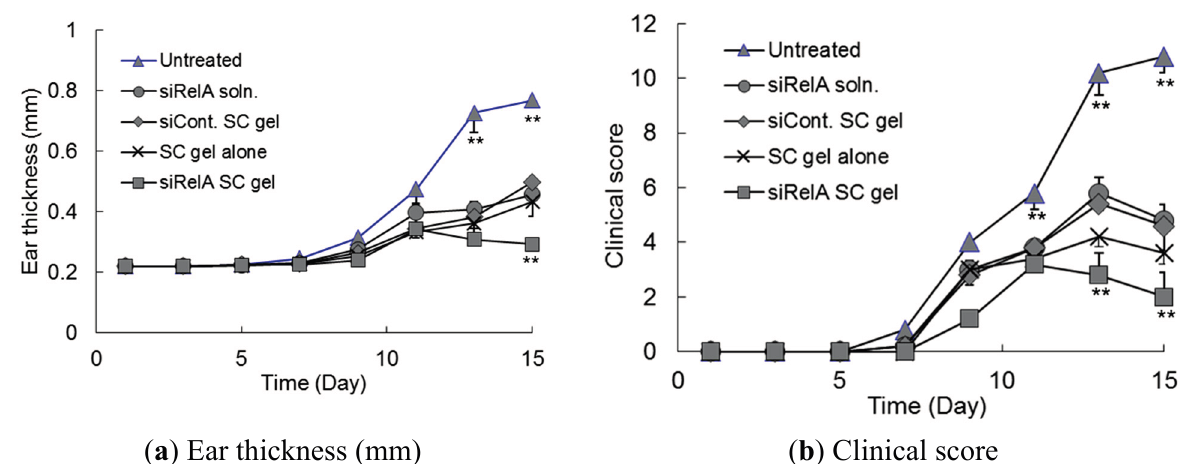
Figure 3. Ear thickness and clinical score assessment of AD-like ear lobes of model